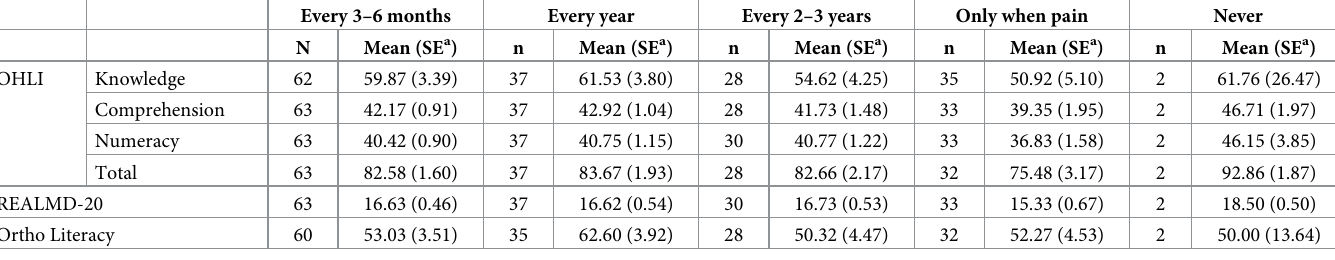
Table 6. Oral health and orthodontic literacy scales by dental visit